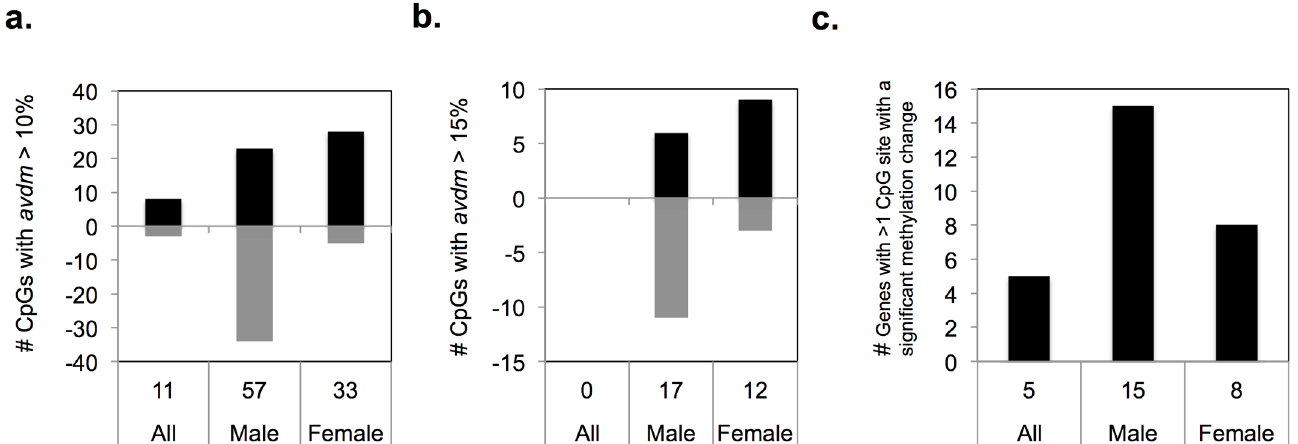
Fig 2. CpG sites with significant changes in DNA methylation. CpG sites with (a) AVDM > 10% and (b) AVDM > 15% and p < 0.001. (a and b) Black indicates methylation increase in DDP. Gray region indicates methylation loss in DDP. (c) Genes with > 1 CpG site with significant change in DNA methylation (p < 0.001).